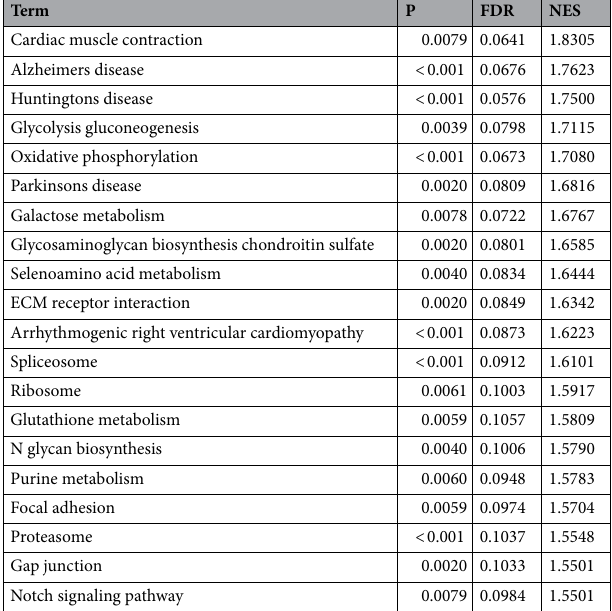
Table 7. The GSEA of CD63 for signaling pathways.